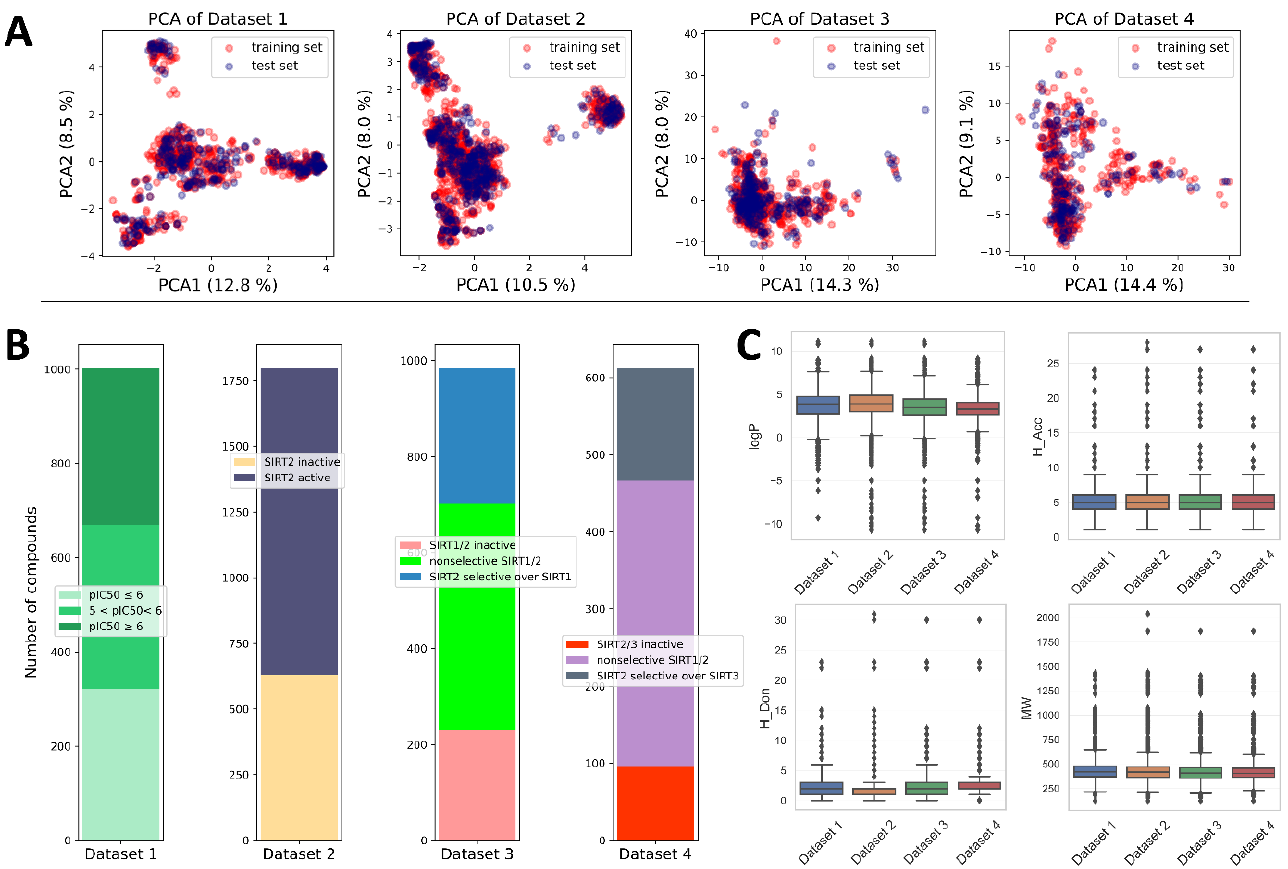
Figure 2. Descriptive statistics of the datasets used in the study. ( A ) PCA analysis of the chemical space of the datasets. PCA plots were calculated in accordance with the descriptors/fingerprints of the final ML models. ( B ) Distribution of data within each dataset. ( C ) Decomposition of datasets onto the Lipinski’s rule of 5.